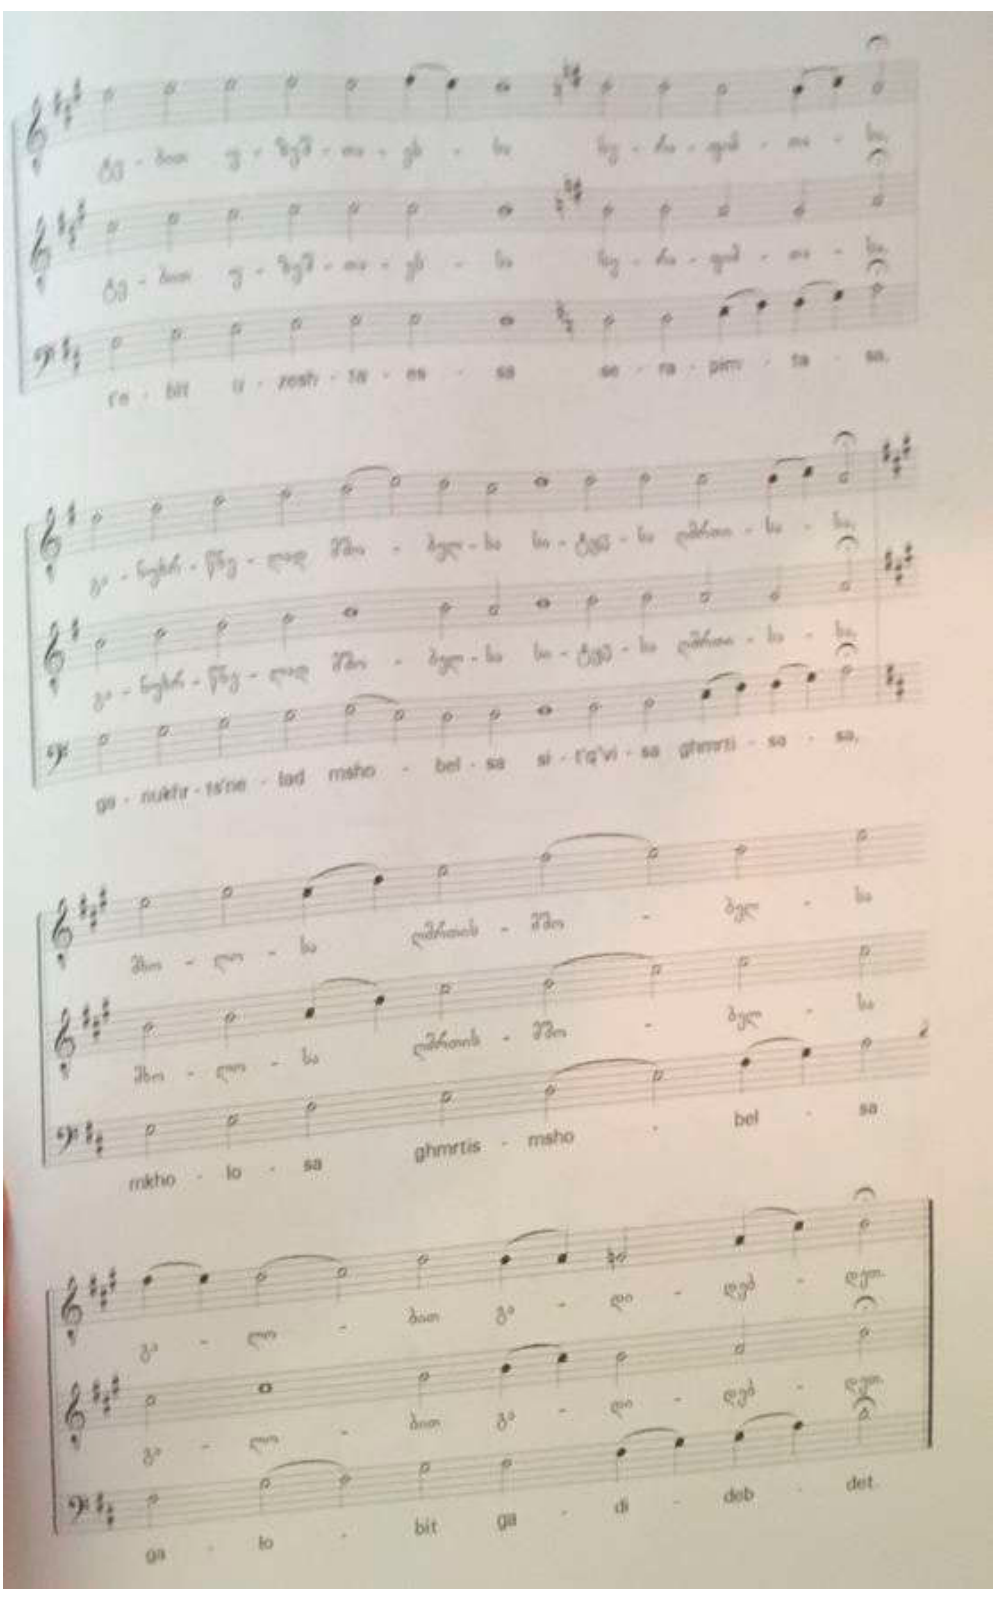
Figure 15. It Is Truly Meet; Shemokmedi School (Shugliashvili et al. 2014).